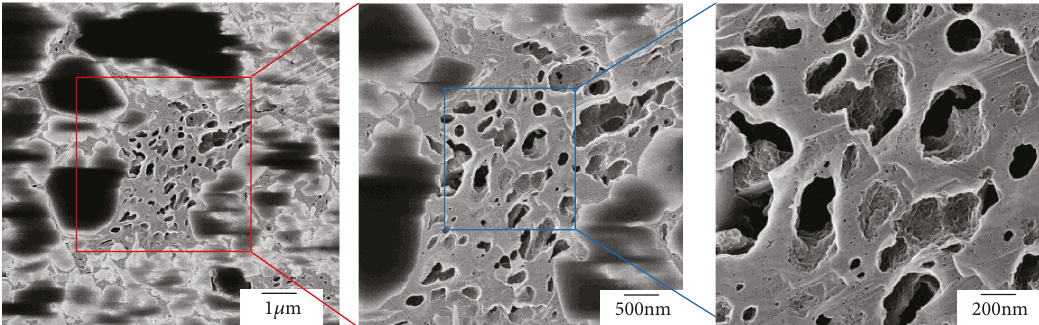
Figure 9: FEB-HIM photos of the organic-rich shale of the Jiaoye-1 Well in the Jiaoshiba block in the Lower Silurian Longmaxi Formation. The burial depth of the samples is 2405m, the TOC is 4.44%, and the Ro is 0.58%. See Figure 1 for the well